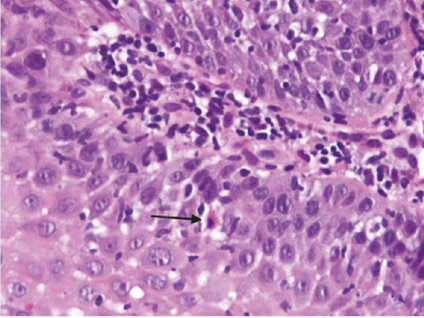
Figure 2: Stricture in the middle third of esophagus.